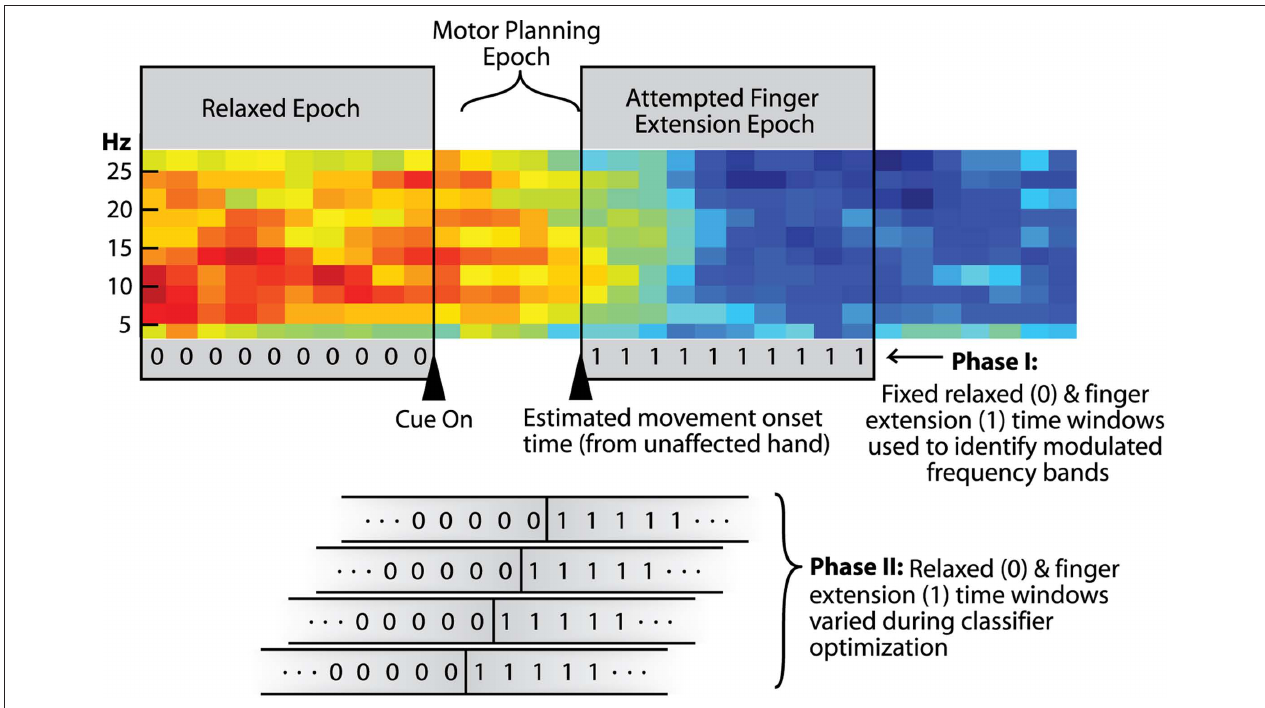
attempted-finger-extension (1) epochs]. Analysis in Phase-II emphasized early detection of attempted-finger-extension during the “movement-preparation” epoch. The lower part of the figure shows how the assigned rest/attempted- finger-extension transition point (0-to-1) was systematically shifted across the movement-preparation epoch in Phase-II as part of the classifier optimization